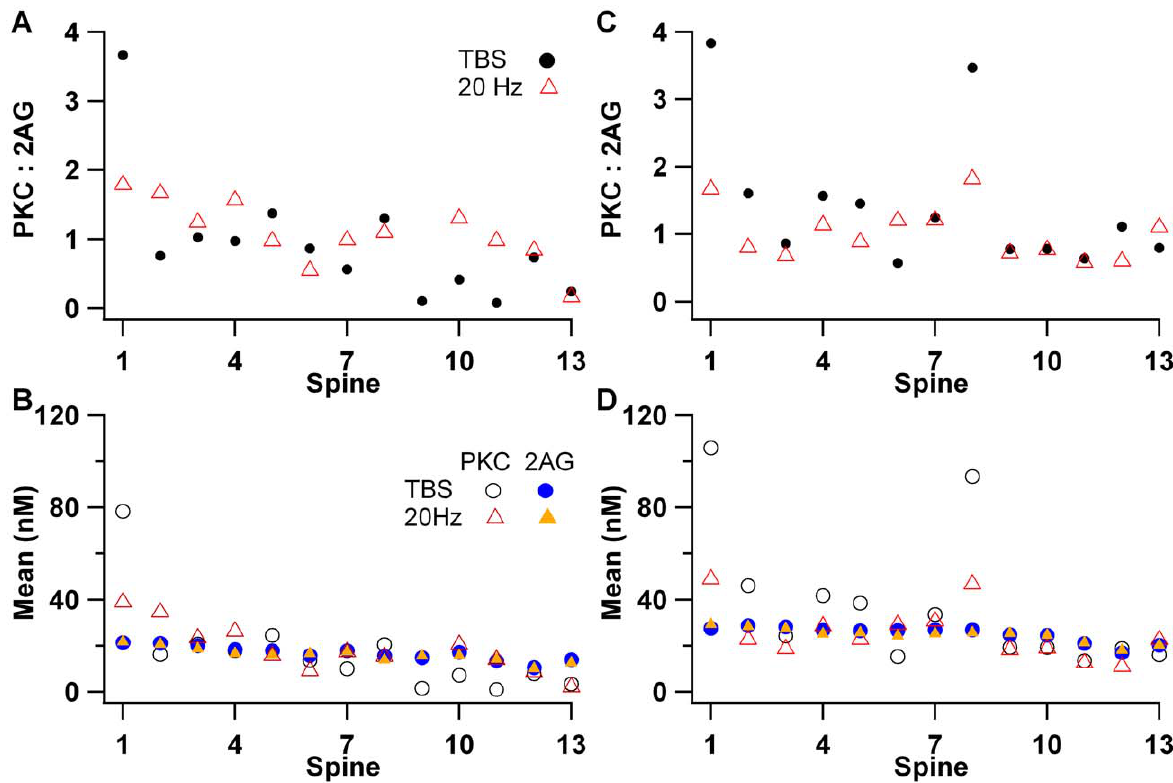
Figure 10. Summary of spatial specificity in 20 m m dendrite with 13 spines (see fig. 1). (A) Ratio of active PKC to 2AG versus spine for both theta burst stimulation (TBS) and 20 Hz stimulation. The ratio is much higher in stimulated spine 1 for TBS, then decreases slightly with distance from the non-stimulated spine. (B) Mean value of active PKC or 2AG exhibits a similar pattern as the ratio. PKC is much greater for the stimulated spine 1, especially for TBS, and PKC activity is close to basal for the four spines furthest from the stimulation. In contrast, 2AG decreases slightly with distance from stimulated spine, independent of stimulation pattern. (C,D) When spines 1 and 8 are stimulated with TBS, the ratio of PKC to 2AG (C), as well as mean PKC activity itself (D), is much higher for the stimulated spines as compared to non-stimulated spines. Mean PKC activity in the non-stimulated spines is slightly higher, but spatial specificity is still strong. Mean 2AG is similar regardless of one or two spines being stimulated.